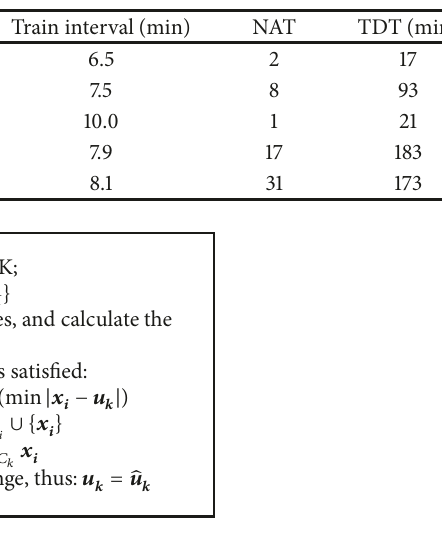
Algorithm 1: K-Means algorithm.